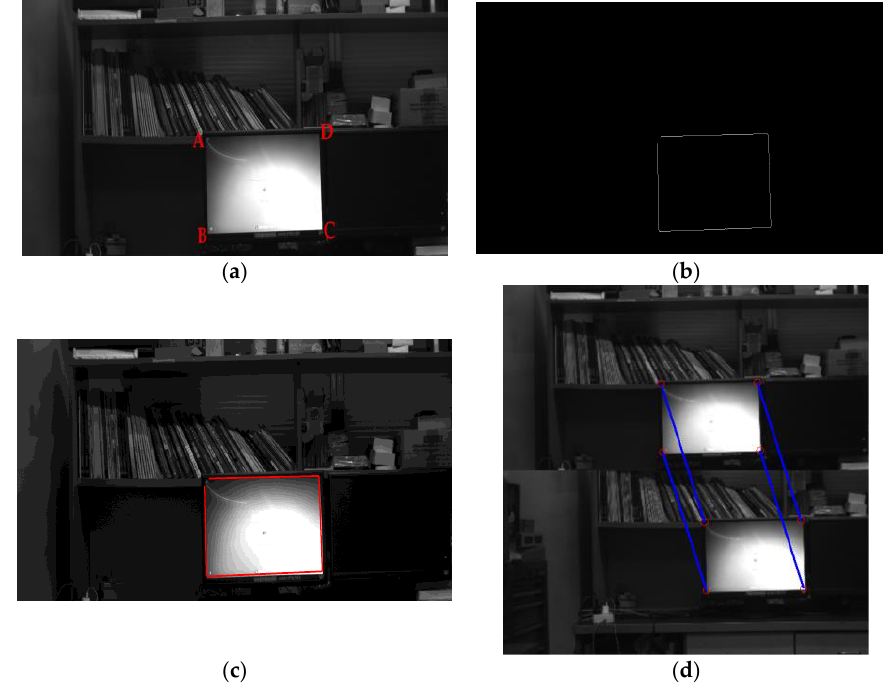
Figure 7. Image processing: ( a ) Source image; ( b ) Canny edge detection; ( c ) Hough line detection; ( d ) Feature point matching.